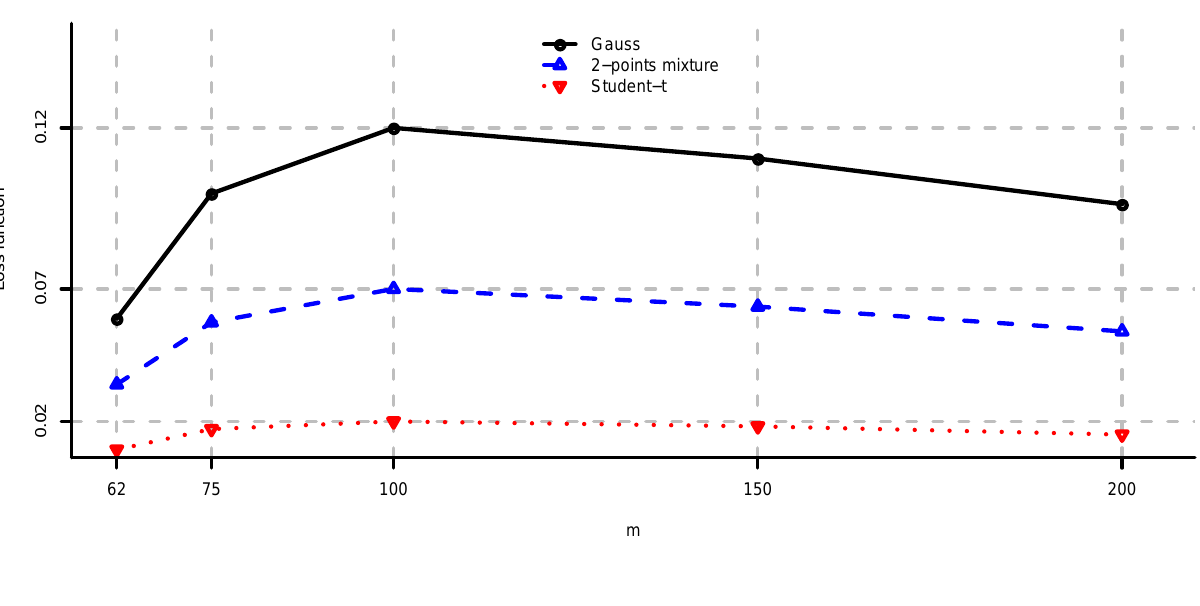
, R n ) computed by simulation ( N = 1000 ) for n = 50 and different Figure 4. L ( U mv , ˆ U mv C , . . . , c values of m . The adjustment factors c are selected according to Equation 1 n